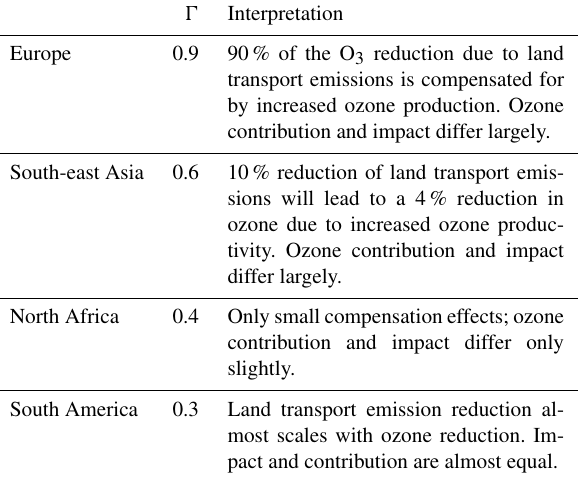
Table 5. Comparison of (cid:48) values (definition see text) between the four considered regions and an interpretation of these